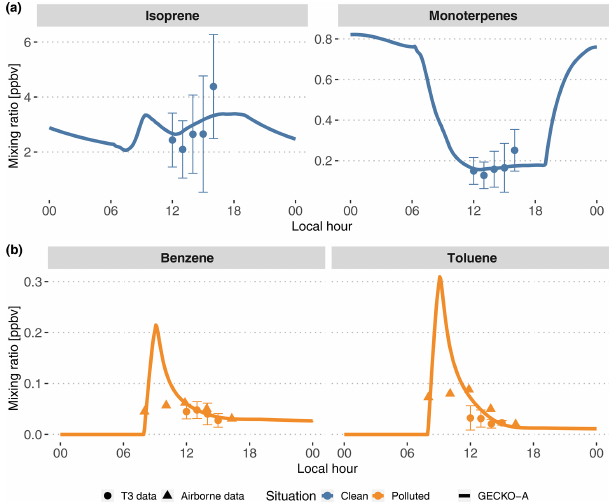
Figure 5. Modeled (lines, second day) time evolution of primary species concentrations in the Lagrangian box model described in Sect. 3.1; average experimental concentrations measured at the T3 site (dots) and in the airplane (triangles). The vertical range of the experimental data denotes the standard deviation of measured con- centrations during events identified as clean (top, blue) and polluted (bottom, orange). The airborne data were measured during plume transects. For each transect, aircraft distance from Manaus was con- verted to a time separation from Manaus assuming the plume leaves the city at 08:00LT and arrives above T3 at